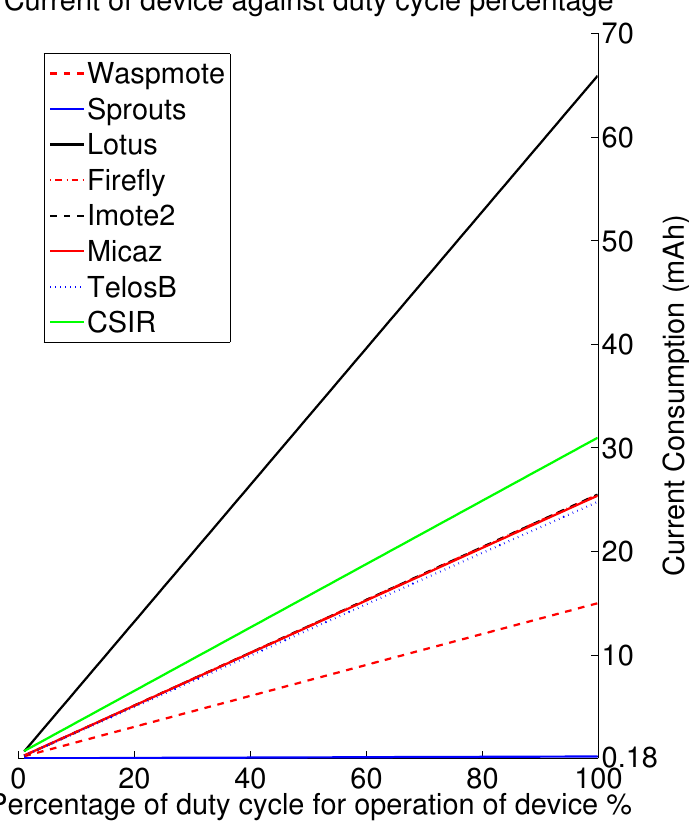
Figure 4. Wireless sensor nodes’ current consumption against duty